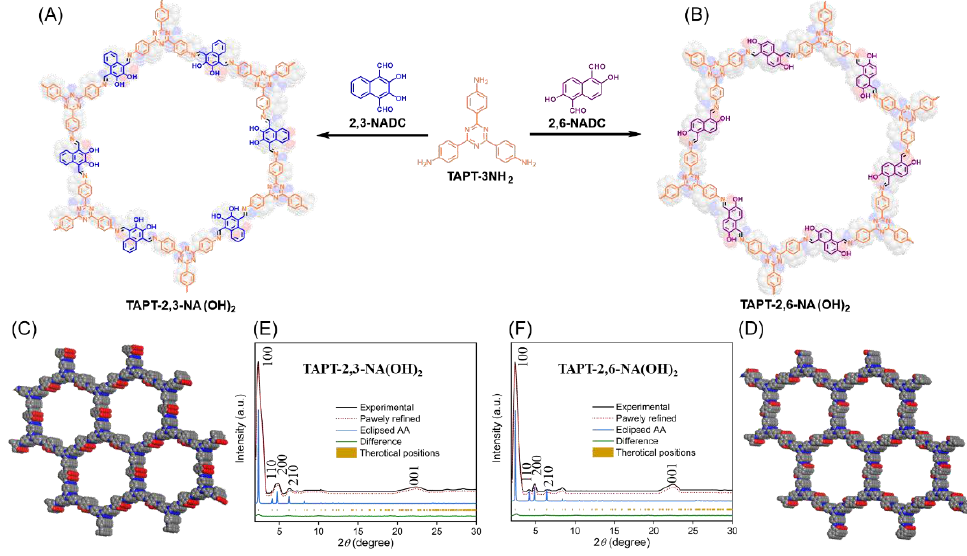
Figure 1. ( A , B ) Synthesis of ( A ) TAPT-2,3-NA(OH) 2 and ( B ) TAPT-2,6-NA(OH) 2 COFs. ( C , D ) Top-view crystal structures of ( C ) TAPT-2,3-NA(OH) 2 and ( D ) TAPT-2,6-NA(OH) 2 crystal structures of ( C ) TAPT-2,3-NA(OH) 2 and ( D ) TAPT-2,6-NA(OH) 2 COFs. ( C , D ) Experimental COFs. ( C , D ) Experimental and simulated PXRD patterns of ( E ) TAPT-2,3-NA(OH) 2 and and simulated PXRD patterns of ( E ) TAPT-2,3-NA(OH) 2 and ( F ) TAPT-2,6-NA(OH) 2 ( F ) TAPT-2,6-NA(OH) 2 COFs.